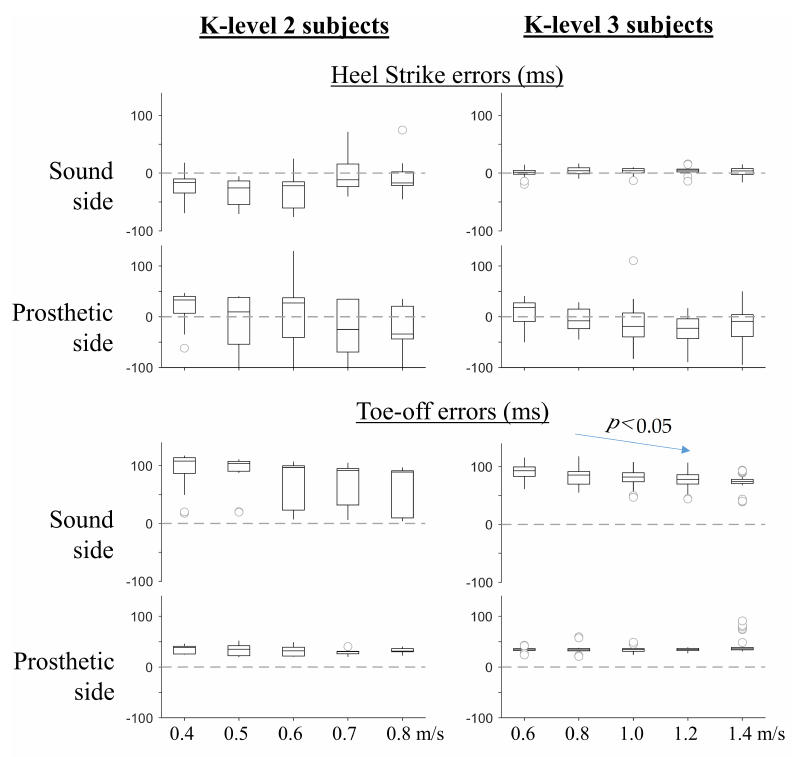
Figure 4. Toe-off ( top panel ) and Heel-strike ( bottom ) median error values separated by subject groups (K-level 2 on left and K-level 3 on right) and leg side. Speed is varied on the x-axis for each group (0.4 to 0.8 m/s for K2 subjects, 0.6 to 1.4 m/s for K3 subjects). Statistically significant difference was found for TO prediction error on the sound side for K3 group (Friedman test, p < 0.05, indicated by an